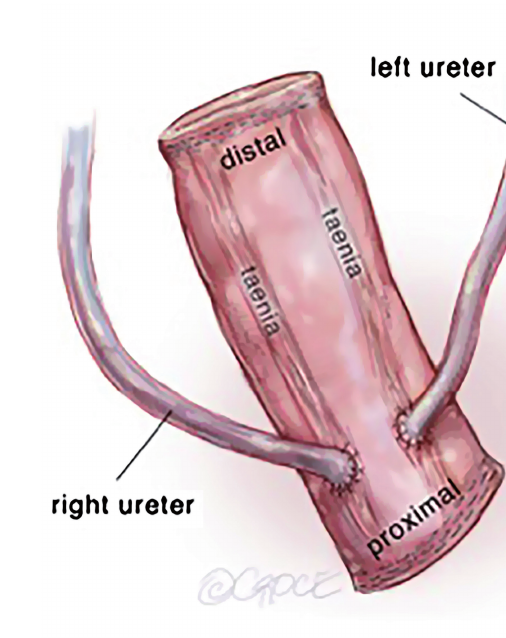
Figure 4 - Uretero-sigmoid anastomosis.